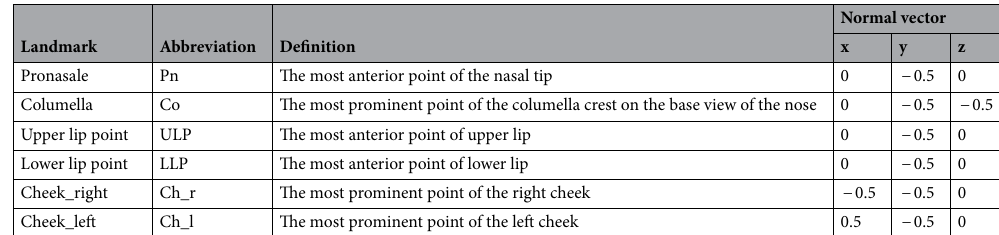
Table 1. Definition and normal vectors of soft tissue protrusion